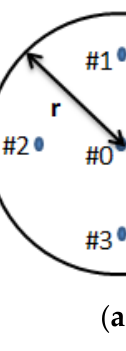
( d ) Figure 4. 3D radiation patterns of the antenna at: ( a ) 0 (cid:2868) ; ( b ) 90 (cid:2868) ; ( c ) 225 (cid:2868) ; ( d ) 315 (cid:2868) . Figure 5. Reflection coefficient of the antenna. Table 1. ESPAR antenna design parameters. Parameters